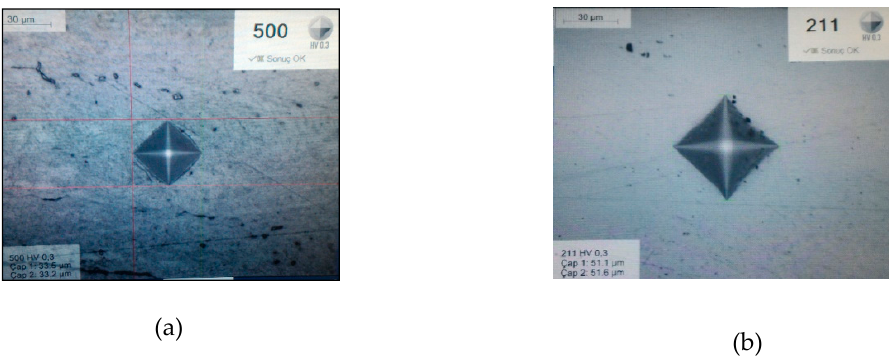
Figure 11. Microvickers test screen views of base metals ( a ) 420; ( b ) 304L (scale: 30 µm).